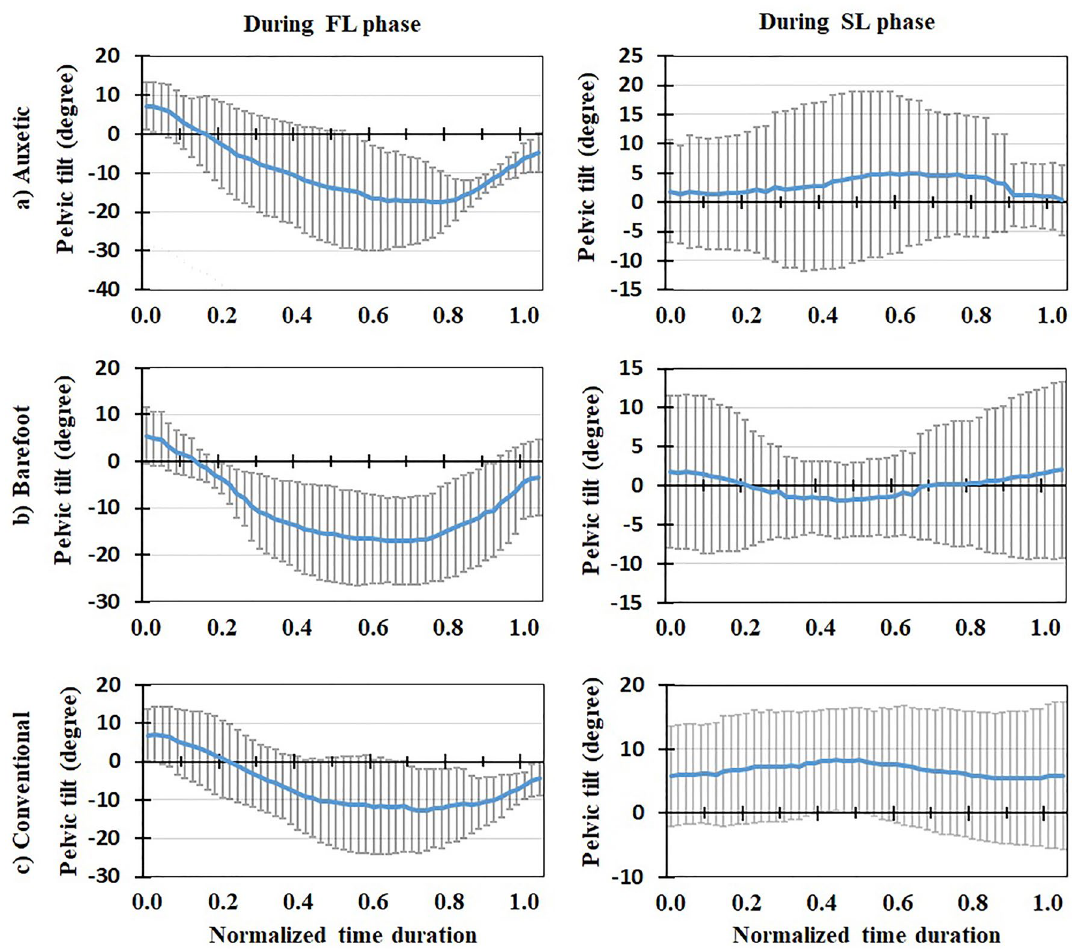
Figure 9. Mean pelvic tilt (degree) for all the participants (+ / − one standard deviation) in three footwear conditions: ( a ) auxetic shoe, ( b ) barefoot, and ( c ) conventional shoe. Left and right plots indicate variations during FL and SL phases of DVJ,